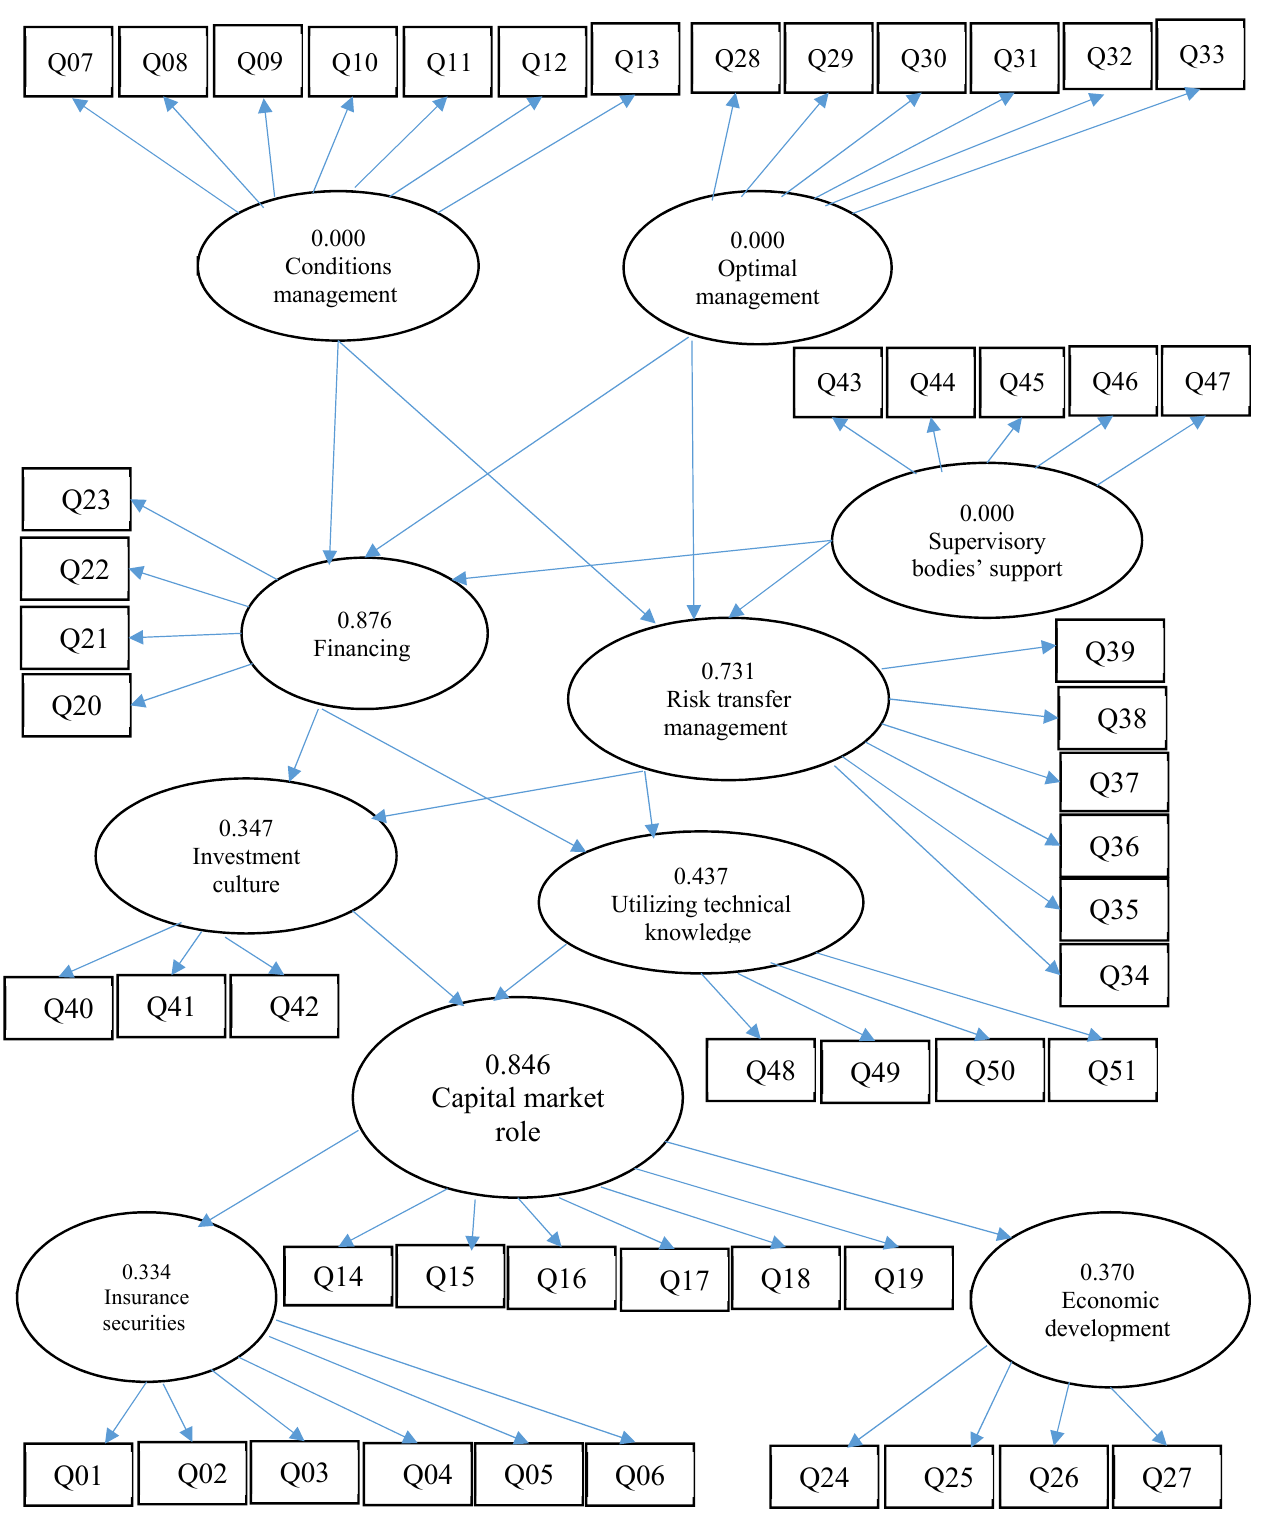
Figure 2. Model validation output with partial least squares method. Source: research